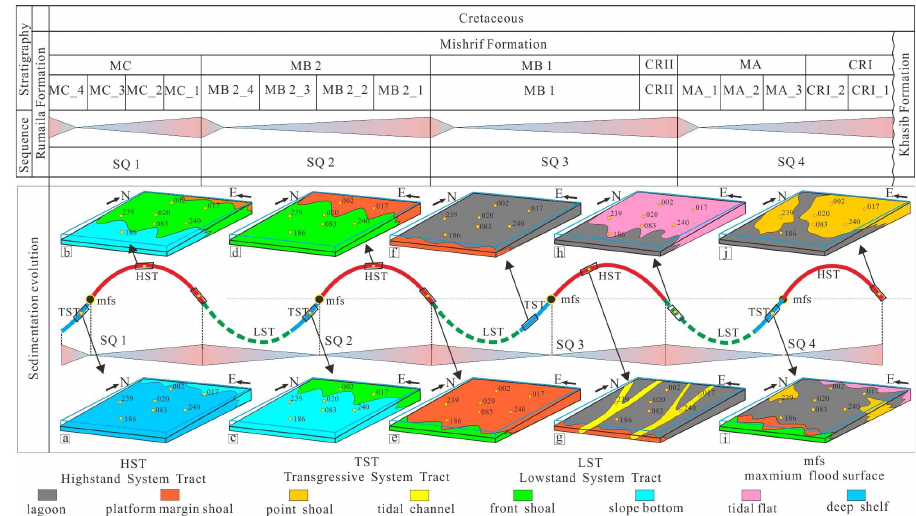
Figure 2. Sequence cycle and sedimentation evolution of the Mishrif Formation in X Oilfield. ( a ) Depositional environment during TST in SQ1; ( b ) depositional environment during the middle HST in SQ1; ( c ) depositional environment during TST in SQ2; ( d ) depositional environment during the middle HST in SQ2; ( e ) depositional environment during the late HST in SQ2; ( f ) depositional environment during TST in SQ3; ( g ) depositional environment during the middle HST in SQ3; ( h ) depositional environment during the late HST in SQ3; ( i ) depositional environment during TST in SQ4; ( j ) depositional environment during the late HST in SQ4.